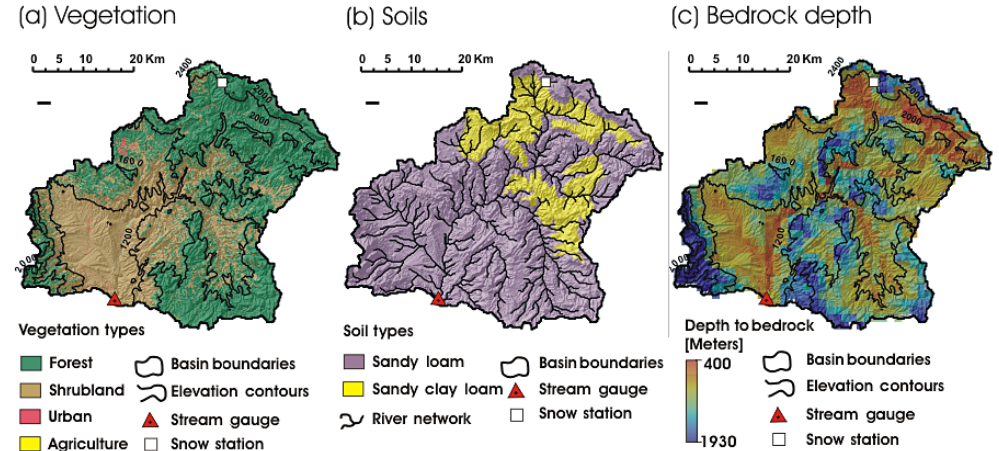
Figure 4. Spatial distribution of (a) vegetation types from USGS National Land Cover Dataset (Homer et al., 2004) at 30m resolution for 2006, (b) soil types from the State Soil Geographic (STATSGO) at 1:250000 scale, and (c) depth to bedrock at 1500m spatial resolution as obtained from the Northern Arizona Regional Groundwater-Flow Model (Pool et al., 2011) clipped for Tonto Creek basin. Elevation contours, hydrography and location of snow (SNOTEL, Promontory) and streamflow (USGS Tonto Creek above Gun Creek) stations are also